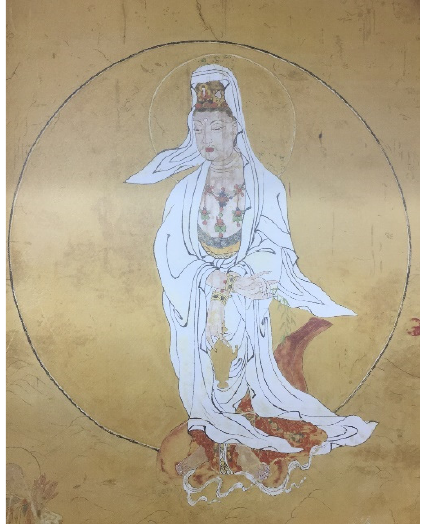
Figure 12. Mural painting of White-clad Avalokitesvara , Joseon dynasty (15th century), Geungnakjeon Hall at Muwisa 無爲寺 Temple (Research Institute of Sungbo Cultural Heritage 2012, p. 50).